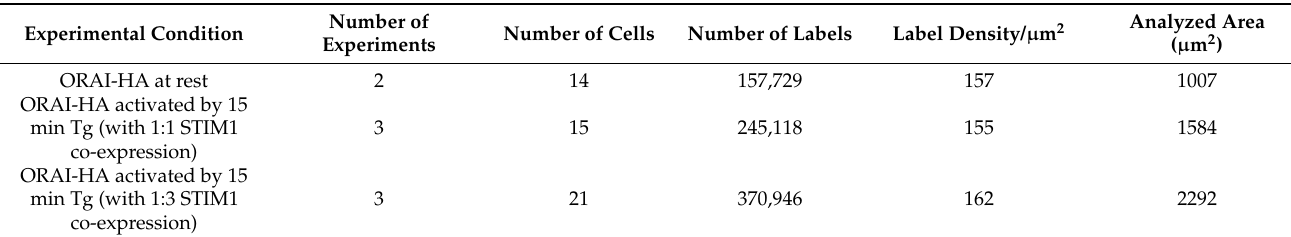
Table 1. Data of ORAI1 labeling experiments including the experiment type. Conditions are at rest, at sub-maximal, and at maximal